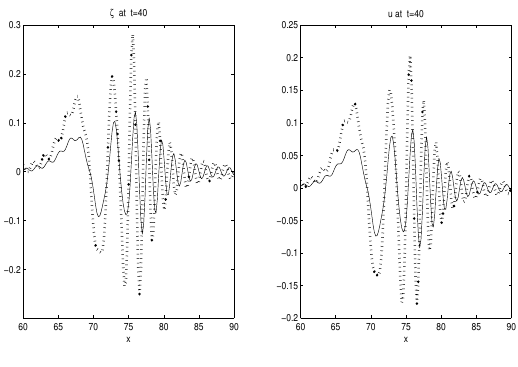
Figure 8. In points: numerical solution of system (1.1) without terms of order O ( (cid:15) 2 ). In solid line: numerical solution of full system (1.1).